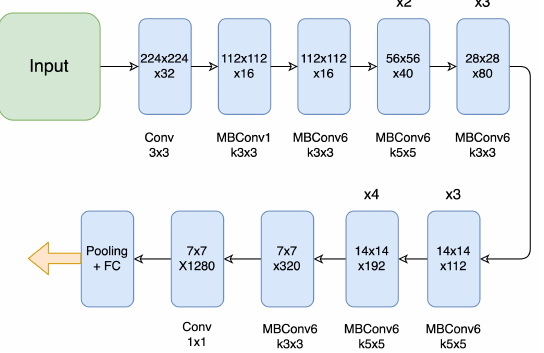
Figure 3. The architecture of EfficientNet [21]. As we can see, it consists of only fewer layers and lesser parameters. The ‘x’ marks on the top indicate the number of such layers